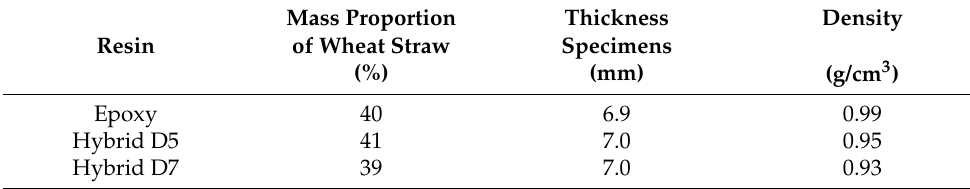
Table 1. Individual values of the chemical composition for the analyzed areas. Mass Proportion Thickness Density Resin of Wheat Straw Specimens (%) (mm) (g/cm 3 ) Epoxy 40 6.9 0.99 Hybrid D5 41 7.0 0.95 Hybrid D7 39 7.0